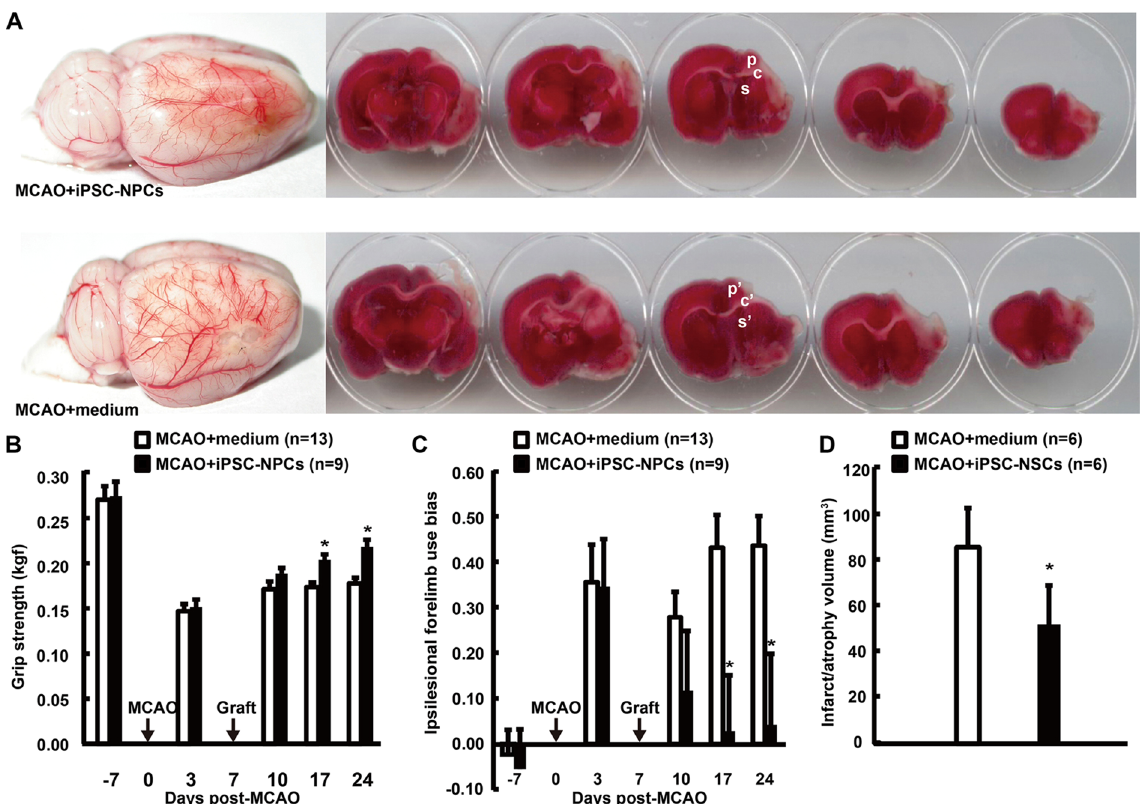
Figure 2. iPSC-NPC engraftment reduced the lesion volume and improved functional recovery after MCAO. ( A ) Representative brains and derivative slices with vital staining from stroke rats with one-week delayed transplantation of iPSC-NPCs or vehicle via local epidural fibrin glue. At 21 days post-transplantation (dpt), note that the white cortical/subcortical lesions and cavities decreased with iPSC-NPC engraftment. The behavioral performance of left paretic forelimbs were progressively monitored using the grip strength test ( B ) and the cylinder test ( C ). The iPSC-NPC group showed functional improvement from 10 dpt compared with the control group. ( D ) The histological analyses at 21 dpt showed that the iPSC-NPC group had reduced lesion volume compared with the controls. p, p’: peri-infarct cortex; c, c’: corpus callosum; s, s’: subventricular zone; indicating the locations of representative pictures in Fig. 3. The results are expressed as mean ± standard error of the mean (SEM). * P <